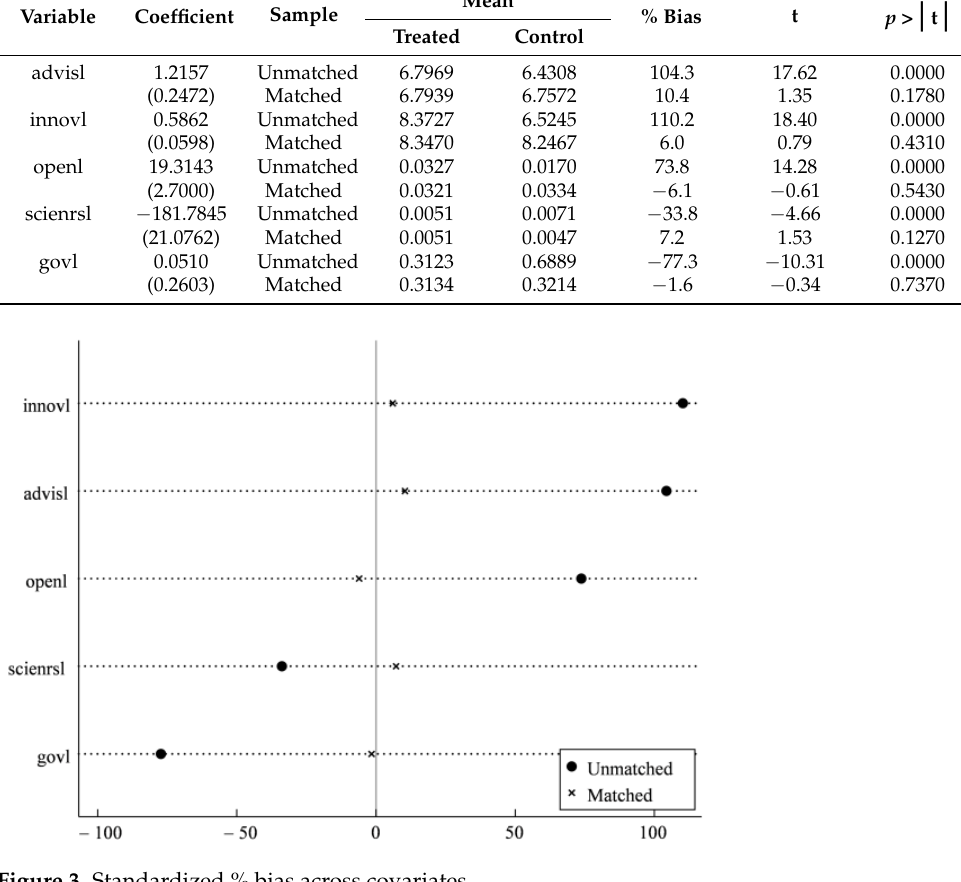
Figure 3. Standardized % bias across covariates.